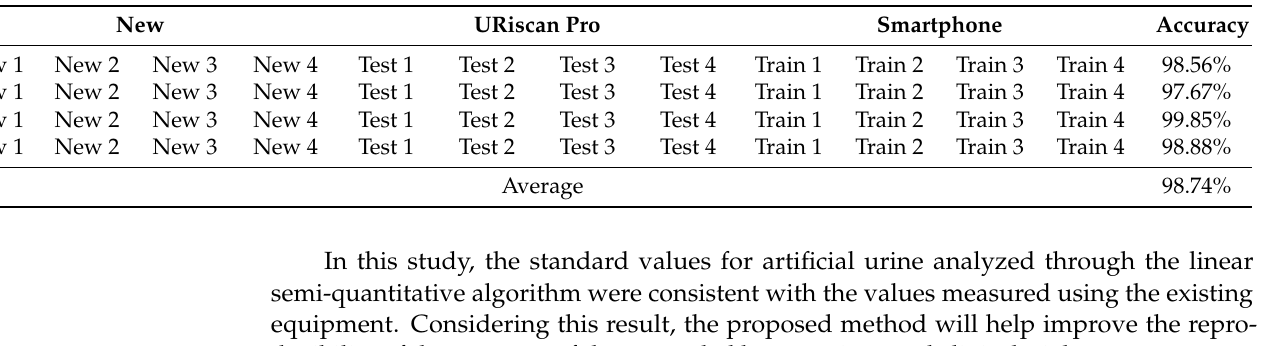
Table 2. Results of application of the urine dipstick confusion matrix